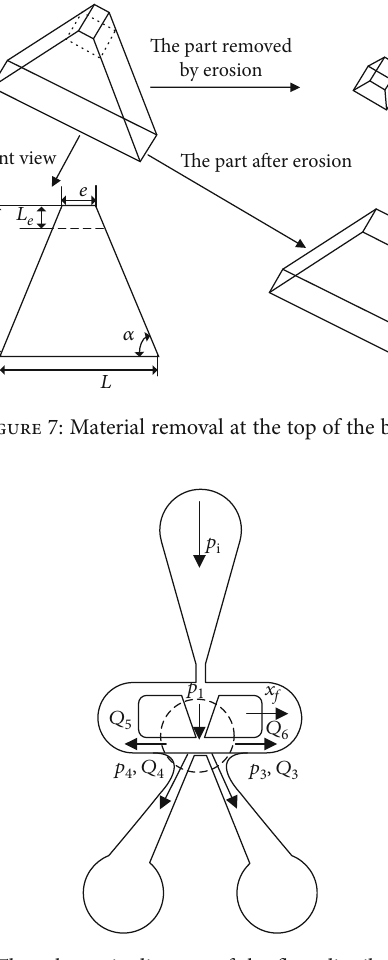
Figure 8: The schematic diagram of the fl ow distribution in pilot stage.